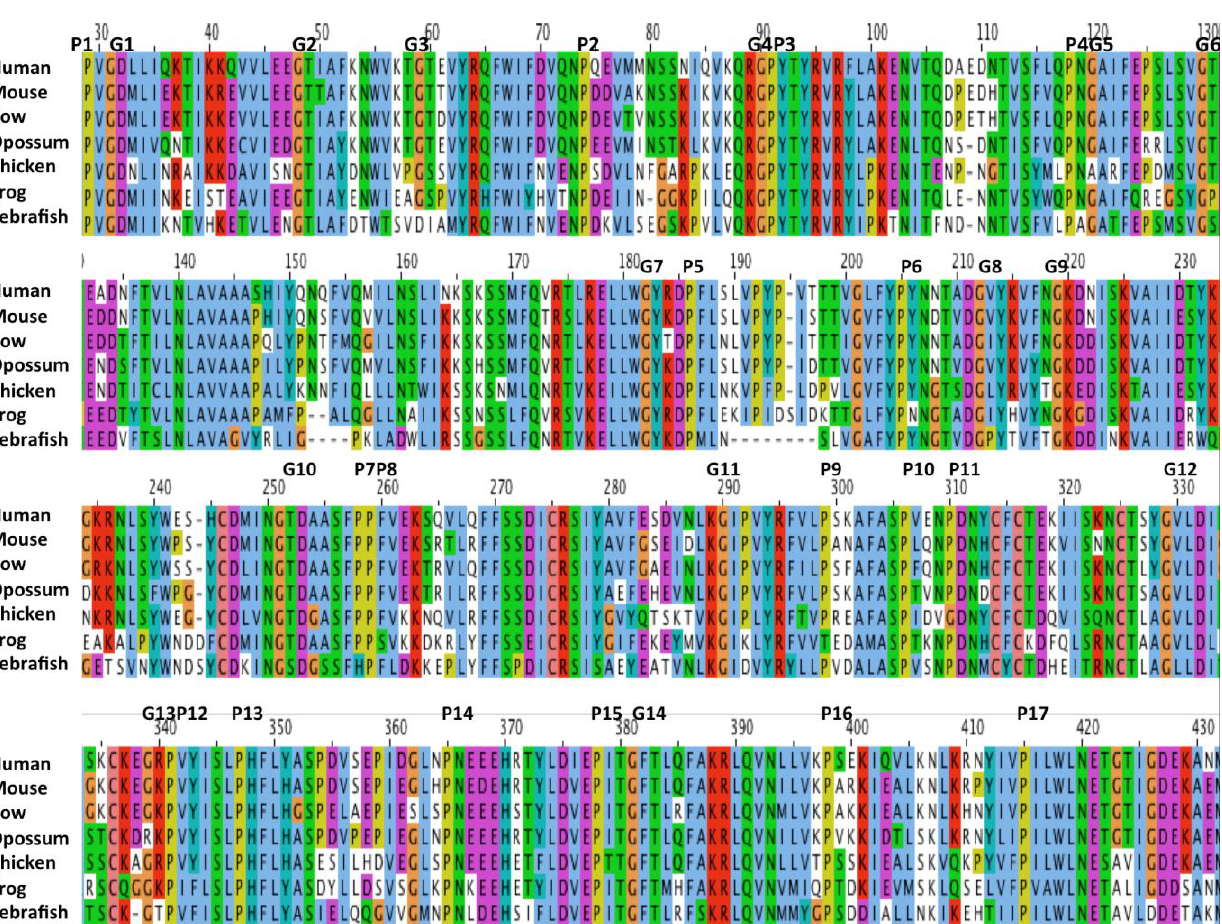
Supplementary Figure 1. Amino Acid Sequence Alignments for Vertebrate CD36 Exoplasmic Sequences. Amino acids are color coded: yellow for proline (P); S (serine); green for hydrophilic amino acids, S (serine), Q (glutamine), N (asparagine), and T (threonine); brown for glycine (G); light blue for hydrophobic amino acids, L (leucine), I (isoleucine), V (valine), M (methionine), W (tryptophan); dark blue for amino acids, T (tyrosine) and H (histidine); purple for acidic amino acids, E (glutamate) and D (aspartate); and red for basic amino acids, K (lysine) and R (arginine); conserved prolines and glycines are designated as P1, P2 etc and G1, G2 etc, respectively. Numbers refer to human CD36 amino acid